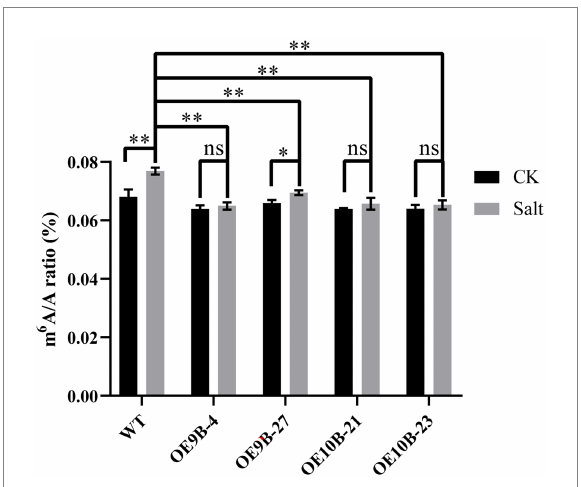
FIGURE 6 Global N 6 -methyladenosine (m 6 A) RNA methylation level in WT and transgenic lines under normal conditions and salt treatment. The data represented averages ± SE of three replicates. The different letters indicated significant differences between different tissue ( * p < 0.05, ** p <